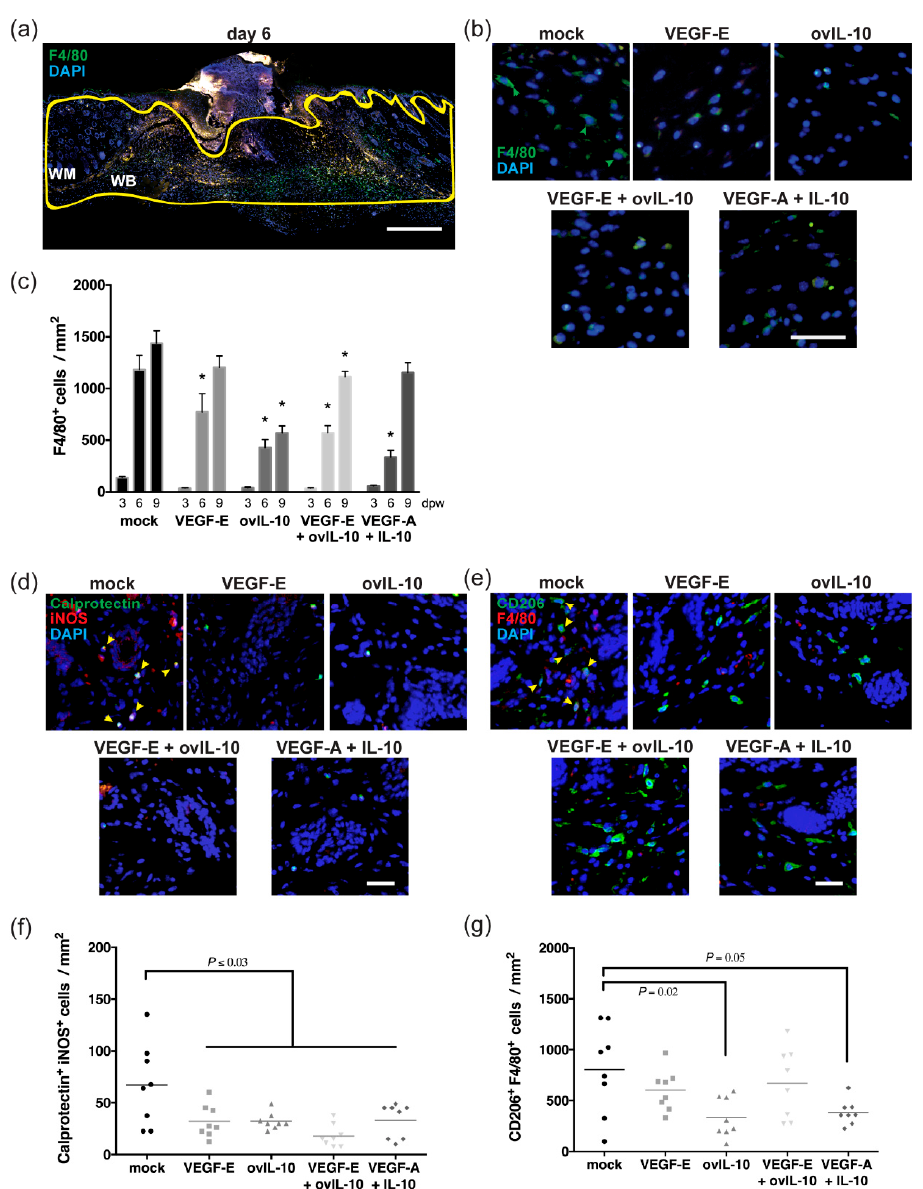
Figure 3. VEGF-E and ovIL-10 have complimentary effects on the response of macrophages to wounding. ( a ) Representative image of a day 6 wound section, stained with antibody to F4/80 (green) and the nuclear stain DAPI (blue). The wound bed (WB) and wound margin (WM) are outlined with a yellow line. Scale bar = 300 µm. ( b ) Representative images of the WM adjacent to the WB in day 6 wound sections after two SC injections of the indicated treatment. Stained macrophages indicated by green arrows. Scale bar = 50 µm. ( c ) Number of F4/80 +ve macrophages per mm 2 in the WB and WM at 3, 6 and 9 days post-wounding (dpw). Data are presented as the mean ± SEM; n = 8 wounds, with means significantly different from that of mock-treated wounds indicated by an asterisk (*, p ≤ 0.05). Representative image of the WM in day 6 wound sections stained with antibodies to ( d ) calprotectin (green) and iNOS (red), or ( e ) CD206 (green) and F4 / 80 (red), and the nuclear stain DAPI (blue). Co-stained macrophages indicated by yellow arrows. Scale bar = 50 µ m. Number of ( f ) calprotectin + ve iNOS + ve M1 macrophages and ( g ) CD206 + ve F4 / 80 + ve M2 macrophages per mm 2 in the WB and WM at day 6 post-wounding. Data are presented with each symbol representing an individual wound, and the line indicating the mean of 8 wounds, p values are